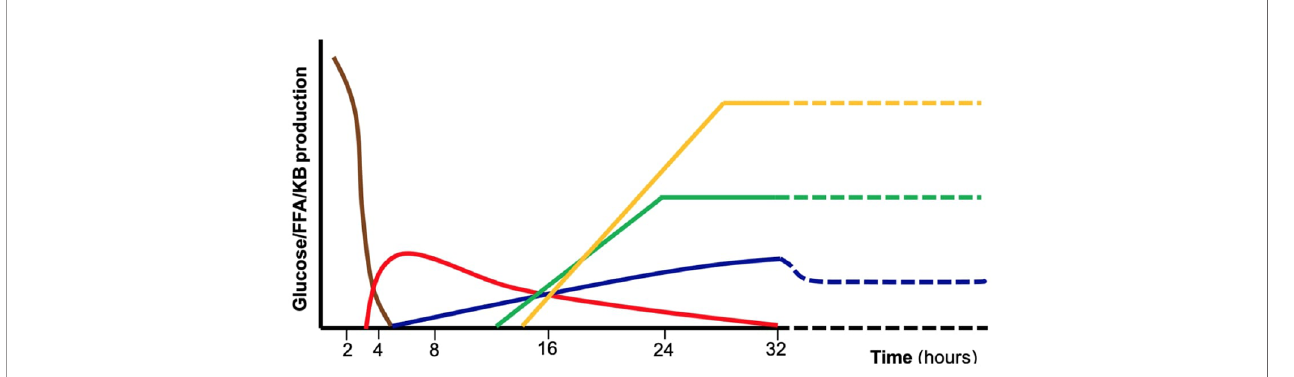
FIGURE 1 | Schematic representation of the major metabolic pathways involved in glucose homeostasis during absorptive phase and fasting including exogenous carbohydrates (brown), glycogenolysis (red), gluconeogenesis (blue), fatty acid oxidation (green), ketogenesis and ketolysis (yellow). These mechanisms are tightly controlled by hormonal regulation. Defects in speci fi c enzymes or transporters involved in those pathways as well as endocrine disorders may result in fasting intolerance and hypoglycemia. FFA, free fatty acids, KB, ketone